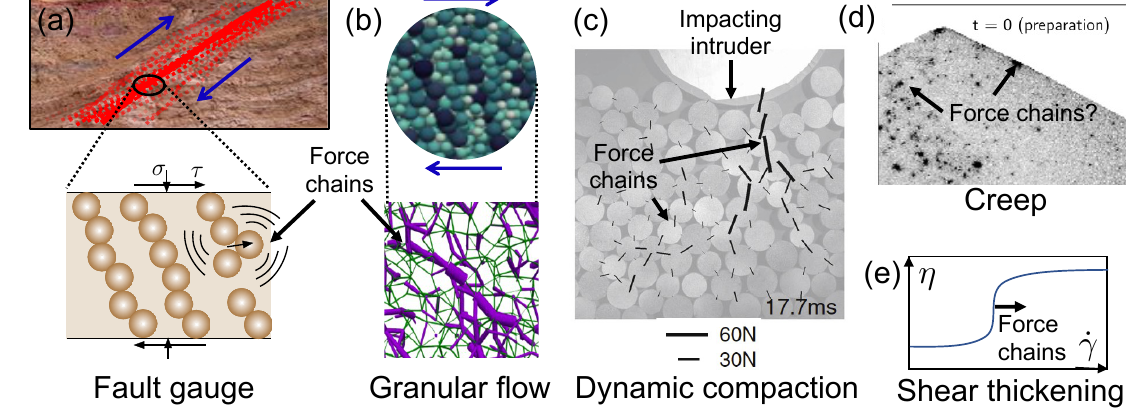
Figure 1: Open challenges in granular mechanics involving force chain dynamics include (a) chain buckling in fault gouge, (b) chain dynamics in granular flows, (c) stress concentrations during dynamic compaction, (d) force chain evolution during creep at the onset of catastrophic flow visualized through diffusing wave spectroscopy (DWS), and (e) force chain formation in discontinuous shear thickening. Images adapted from [15–17] (Open Access) and [18] with